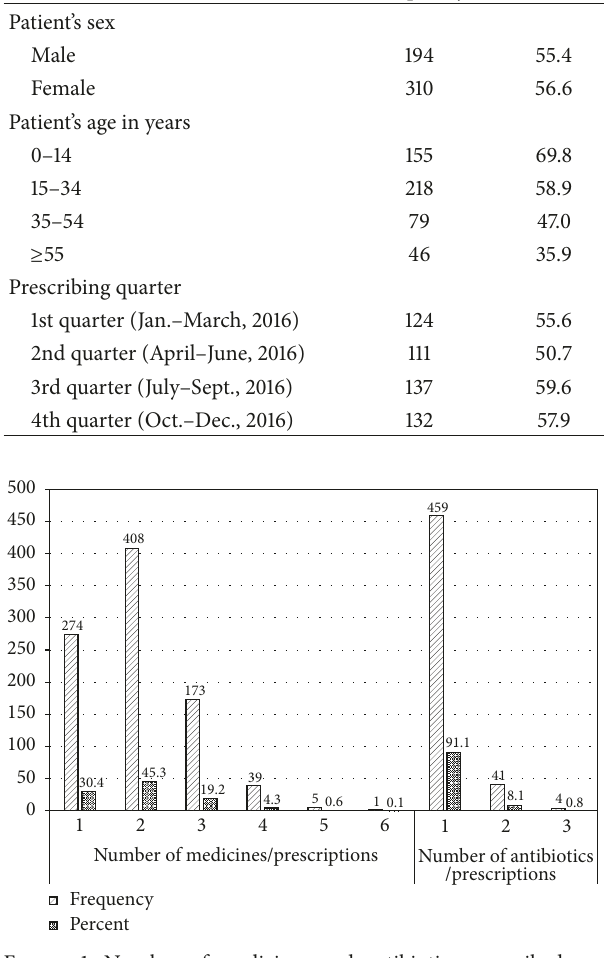
Figure 1: Number of medicines and antibiotics prescribed per prescription at health centers in Addis Ababa, January 1–December 31,